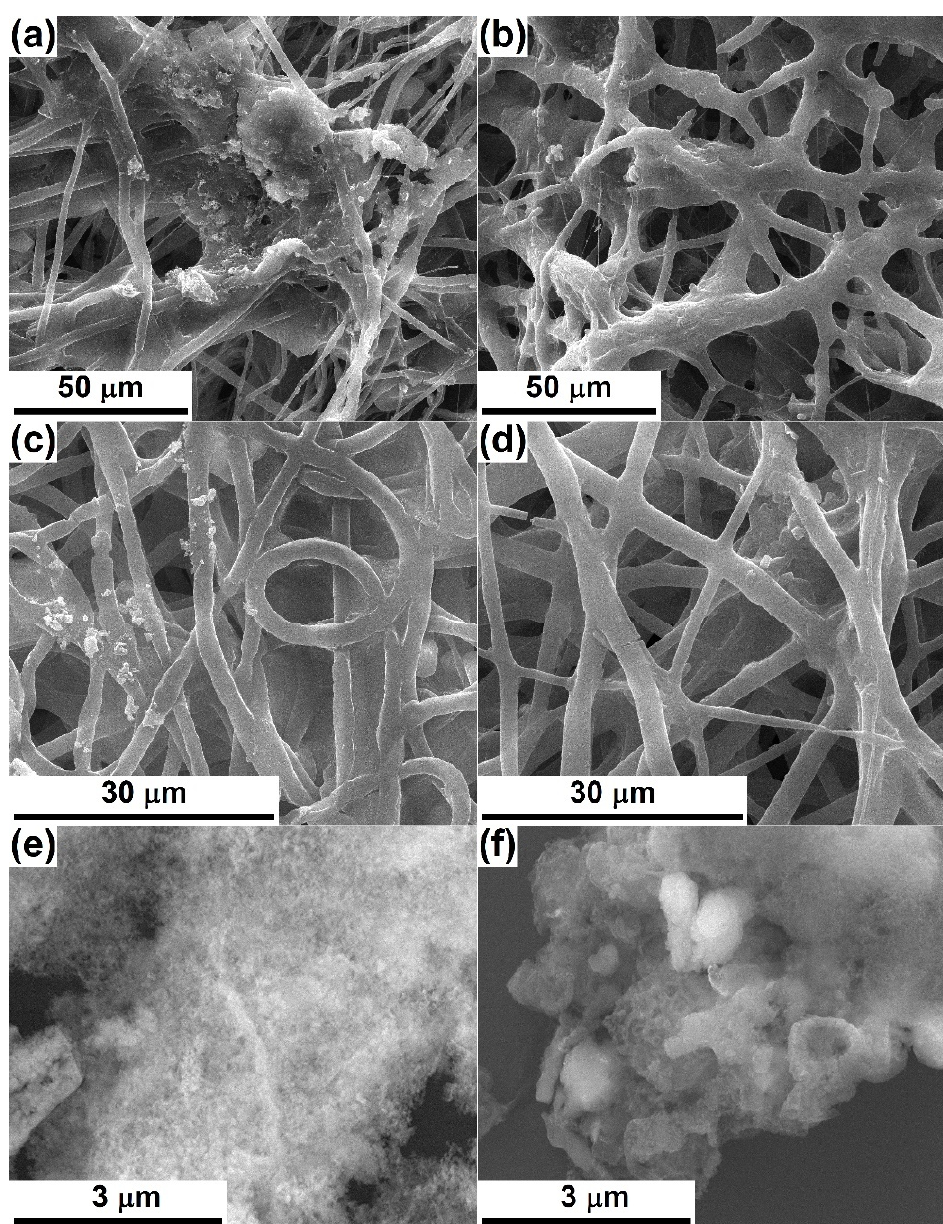
Figure 5. SEM images, based on secondary electrons after four weeks of immersion in SBF, of: ( a ) PCL-Mg-1, ( b ) PCL-Mg-5, ( c ) PCL-Sr-1 and ( d ) PCL-Sr-5 scaffolds, and ( e ) Mg-containing and ( f ) Sr-containing compositions.